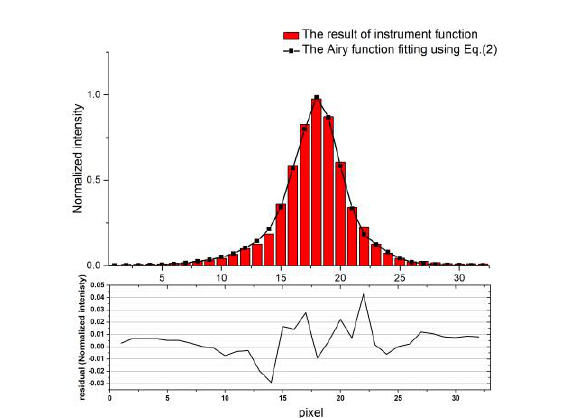
Fig. 4. top: The instrument function measured with the PMT array (red bar) and the best fitting using Eq. (2) of an Airy function (black dots), bottom: the residual of the fitting.